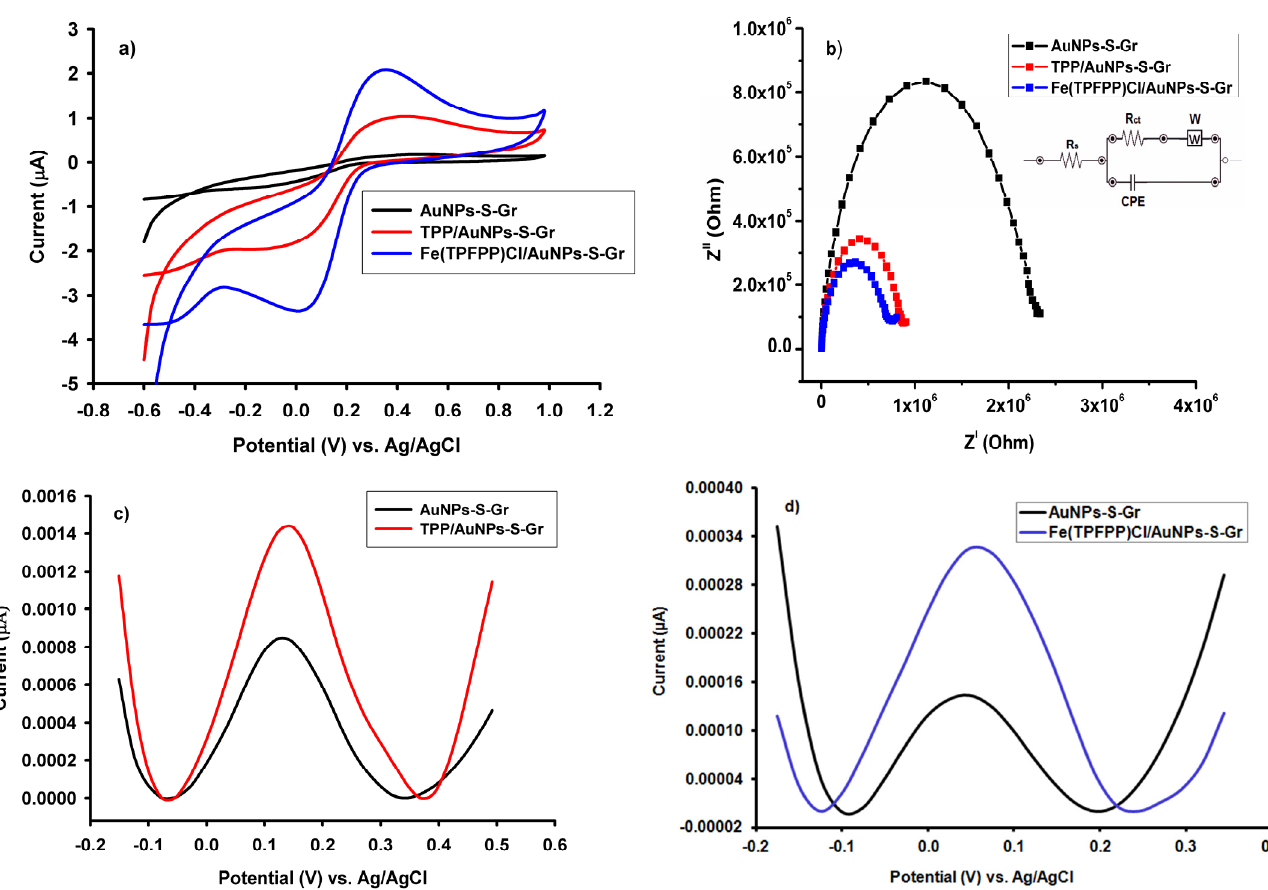
Figure 1. ( a ) Cyclic voltammograms of the current plotted against the potential (working conditions: step potential 0.025 V; scan rate 0.1 V s − 1 ) in a solution of 5.0 × 10 − 3 mol L − 1 K 3 [Fe(CN) 6 ] (0.1 mol L − 1 KCl) using the AuNPs-S-Gr (black line), TPP/AuNPs-S-Gr (red line) and Fe(TPFPP)Cl/AuNPs-S-Gr (blue line). ( b ) Electrochemical impedance spectra recorded for AuNPs-S-Gr (black line), TPP/AuNPs-S-Gr (red line) and Fe(TPFPP)Cl/AuNPs-S-Gr (blue line) in a solution of 5.0 × 10 − 3 mol L − 1 K 3 [Fe(CN) 6 ] (0.1 mol L − 1 KCl) (conditions: frequency range between 1.0 × 10 5 to 1.0 × 10 − 1 Hz). Inset: equivalent circuit diagram of the electrochemical interface used to fit the impedance spectra where R s is the solution resistance, CPE is the constant phase element, R ct is the electron-transfer resistance, and W is the Warburg diffusion resistance. ( c ) The recorded differential pulse voltammograms in PBS pH 2.0 containing 1 × 10 − 4 mol L − 1 R-limonene for the AuNPs-S-Gr (black line) and TPP/AuNPs-S-Gr (red line). ( d ) The recorded differential pulse voltammograms in PBS pH 3.0 containing 1 × 10 − 4 mol L − 1 R-limonene for the AuNPs-S-Gr (black line) and Fe(TPFPP)Cl/AuNPs-S-Gr (blue line).